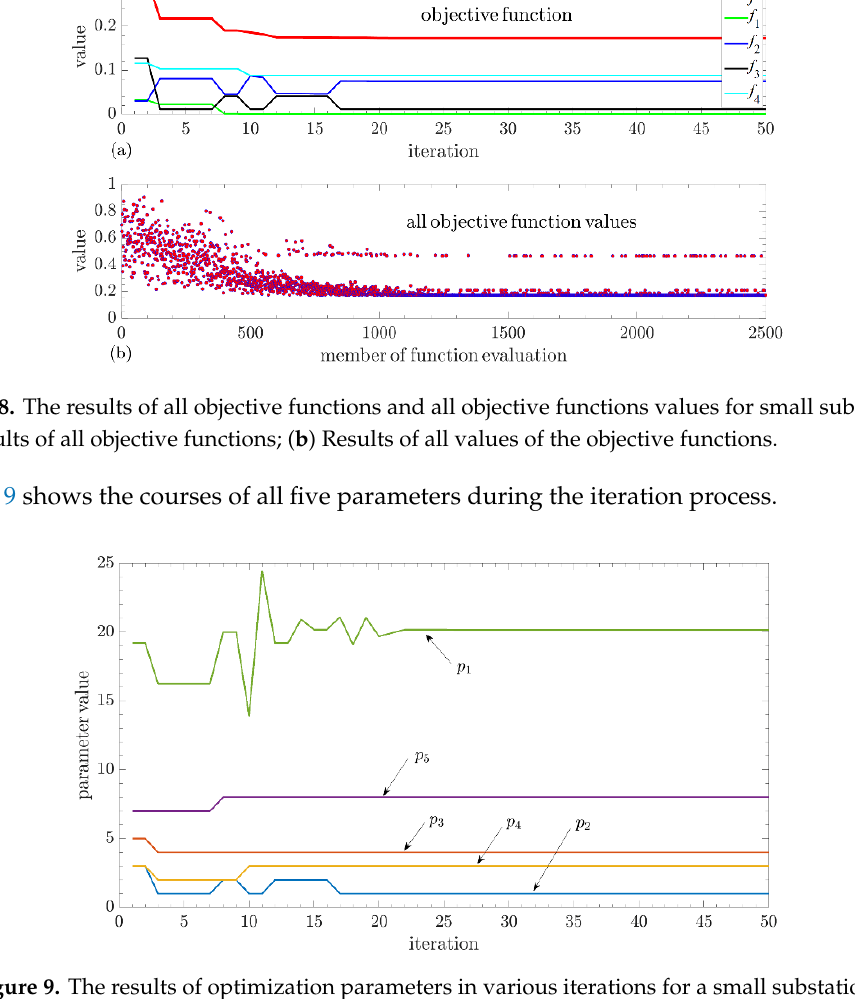
Figure 9. The results of optimization parameters in various iterations for a small substation.